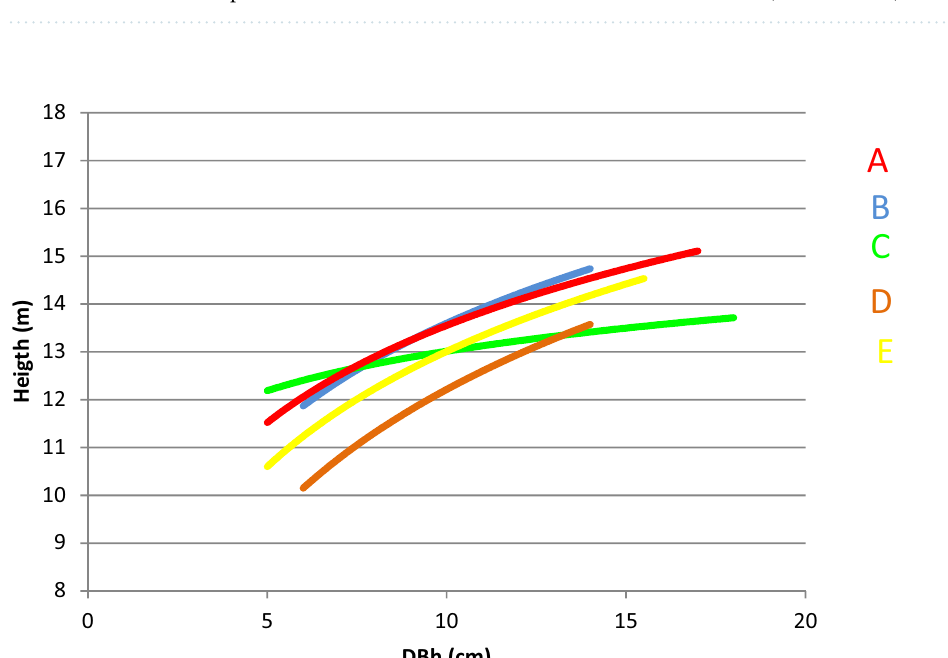
Figure 1. Height-diameter curves of the five chestnut coppices on Amiata mountain. DBH = diameter at breast